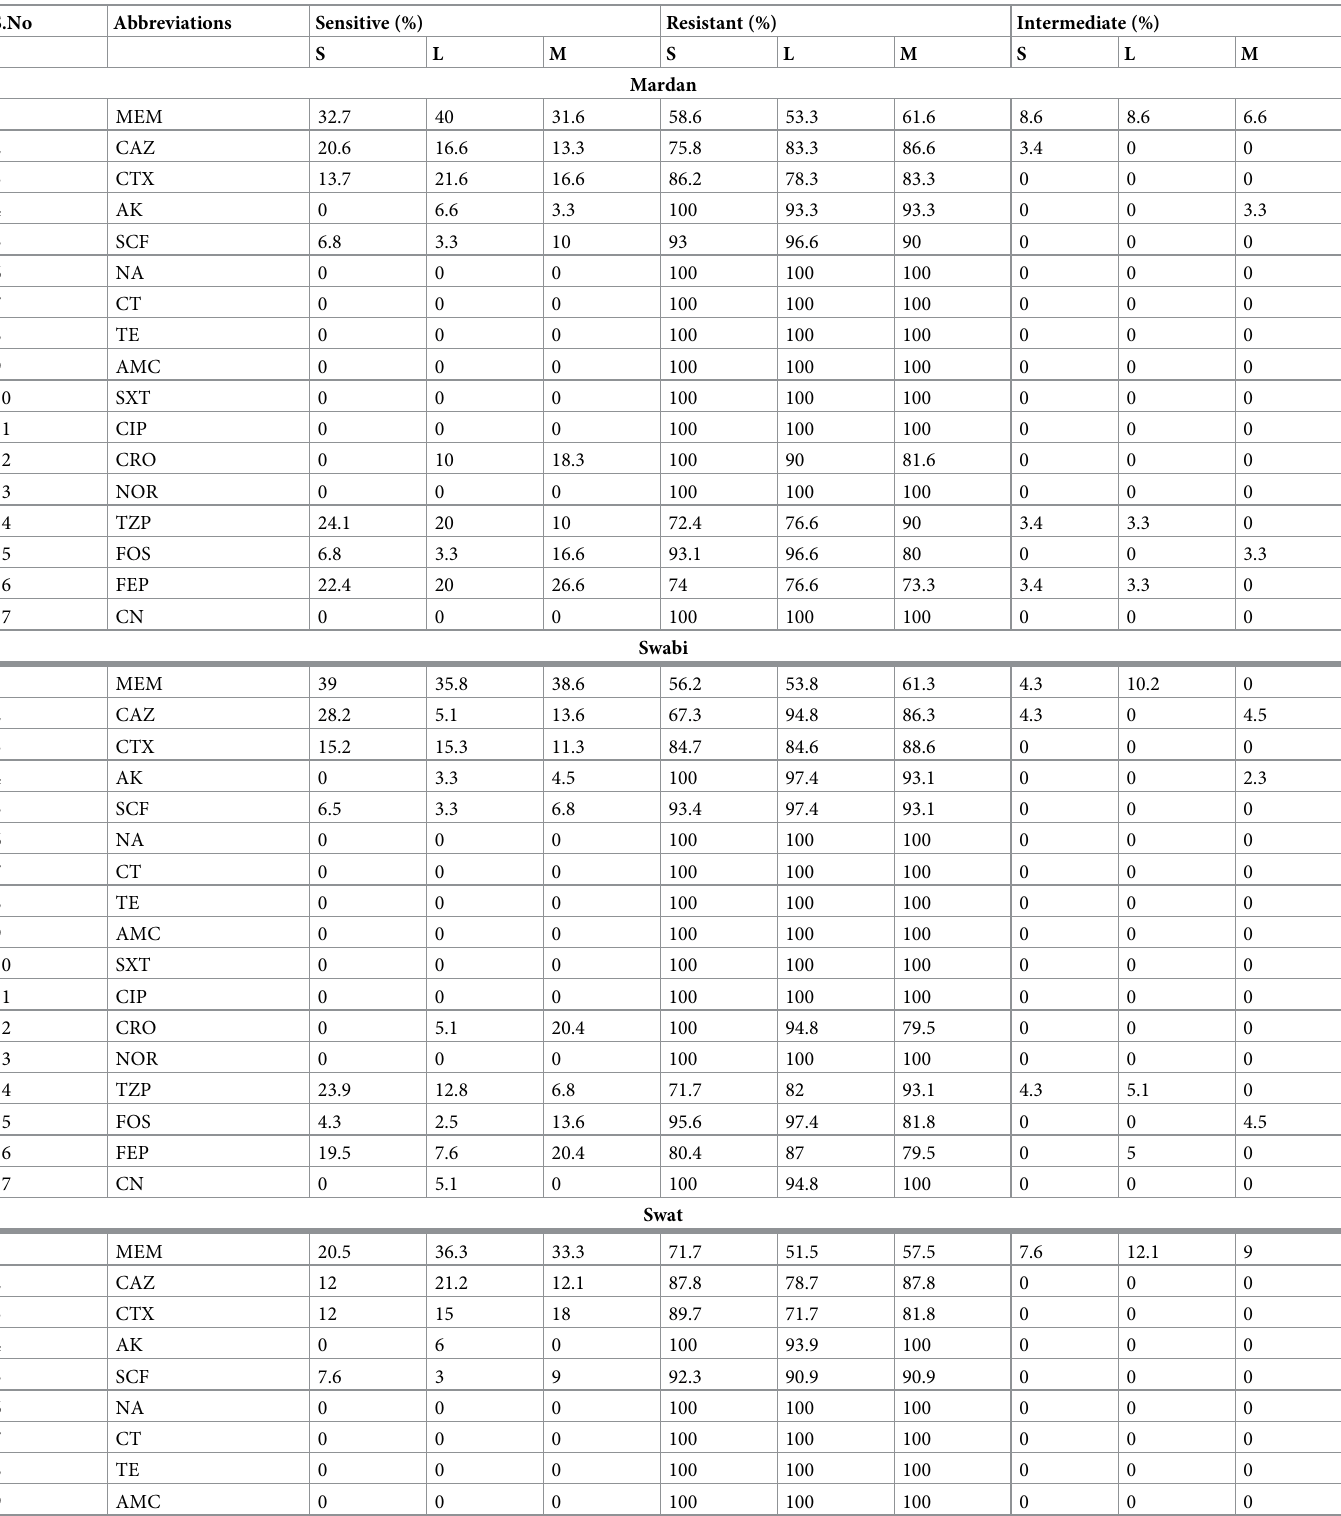
Table 4. Percentage of antibiotic sensitivity pattern of E . coli